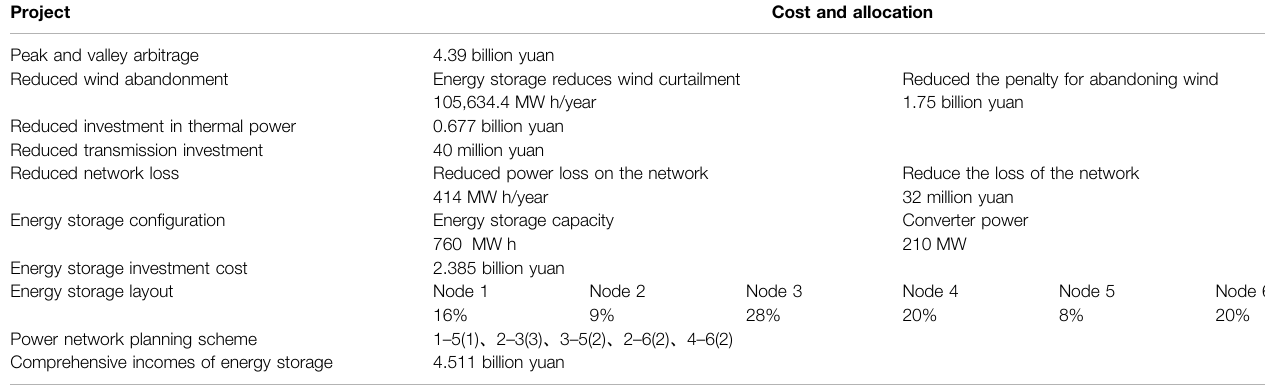
TABLE 3 | Source-storage-transmission planning scheme under power trisection strategy. Project